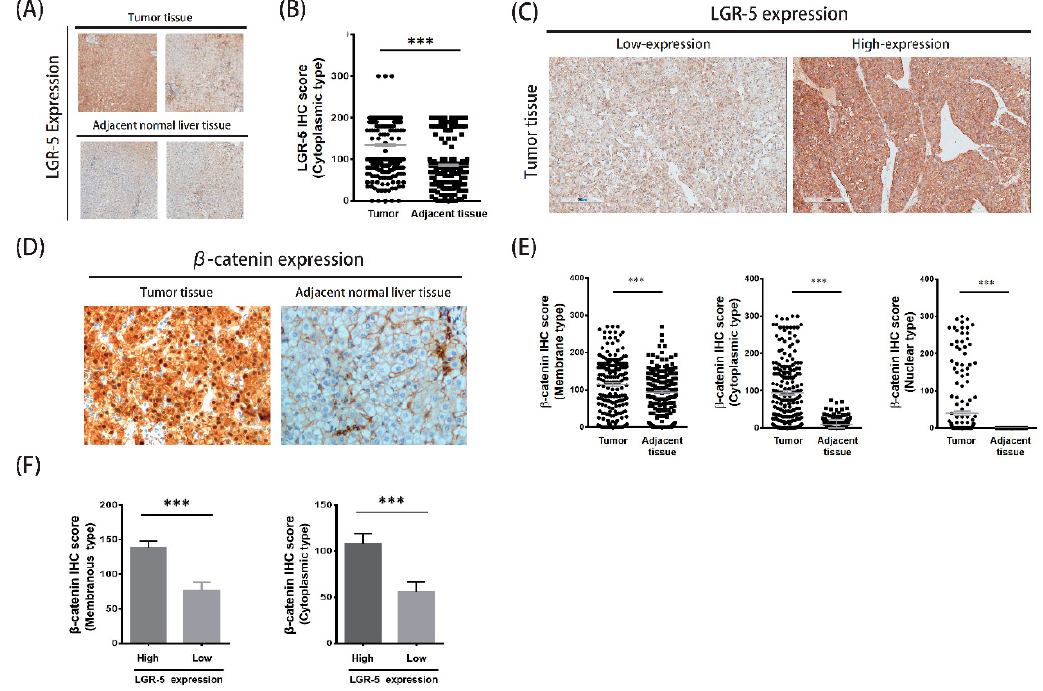
Figure 1. The LGR-5 expression and co-staining β -catenin protein in tumor and matched adjacent normal liver tissue of HCC patients. ( A ) The expression of LGR-5 in tumor and adjacent normal liver tissue. ( B ) The levels of LGR-5 expression in tumor and non-tumor liver tissues of HCC patients. ( C ) The high expression and low expression of tumor tissue. ( D )The co-staining of β -catenin expression in tumor and matched adjacent normal liver tissue of HCC patients. ( E ) Three types of β -catenin expression were higher in tumor and non-tumor liver tissues of HCC patients. ( F ) The β -catenin expression was associated with LGR-5 expression.